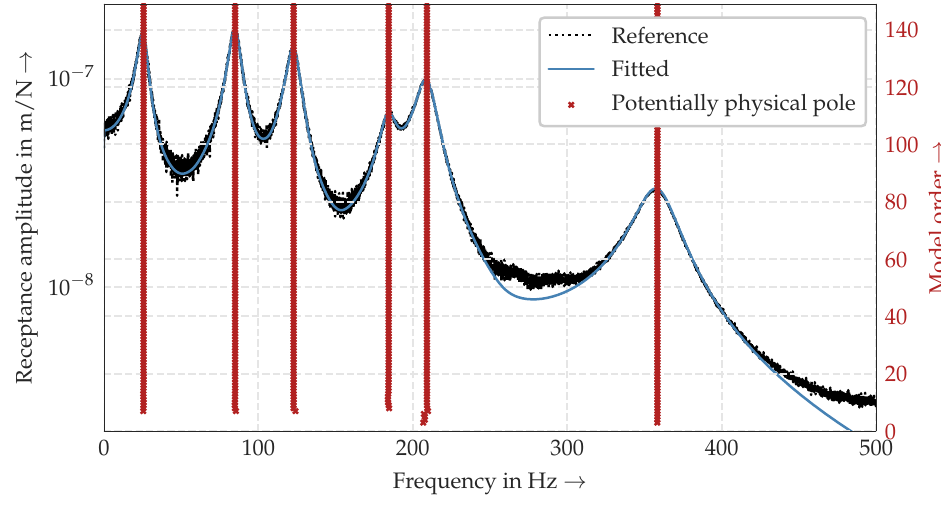
Figure 2. Exemplarily FRF and potentially physical poles identified after applying the PolyMAX algorithm and criteria (a) to (d) (see Section 2.1) for the given hyperparameters k ∆ f , k ∆ D , k Dmin , and k Dmax .